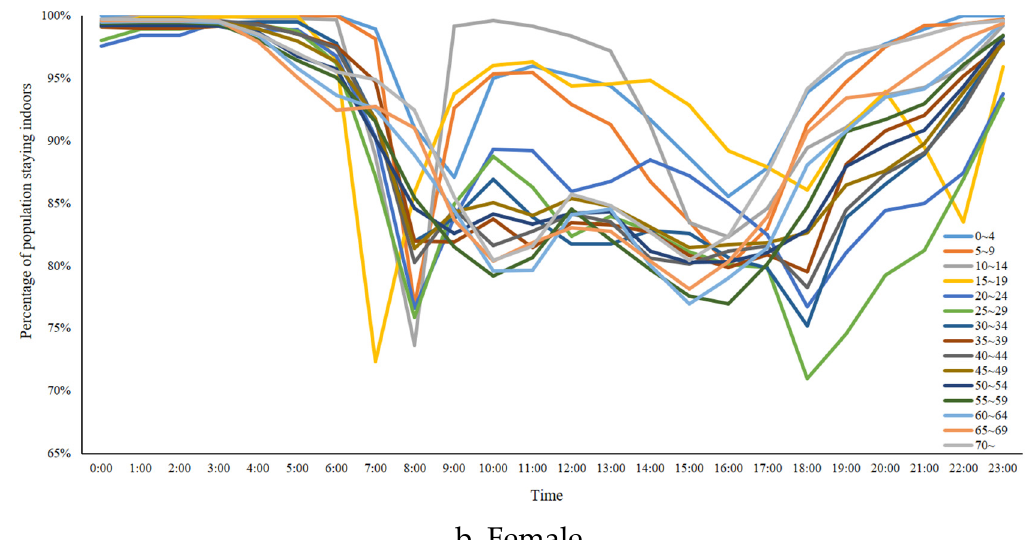
Figure 3. Percentage of population staying indoors by sex, age, and the time of the day in weekday. ( a ) Male ( b ) Female